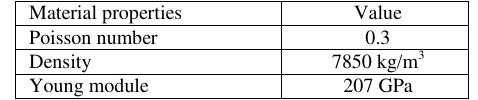
used in simulations are presented in Tables 1 and 2. Table 1. 40HNMA steel material properties used for calculations